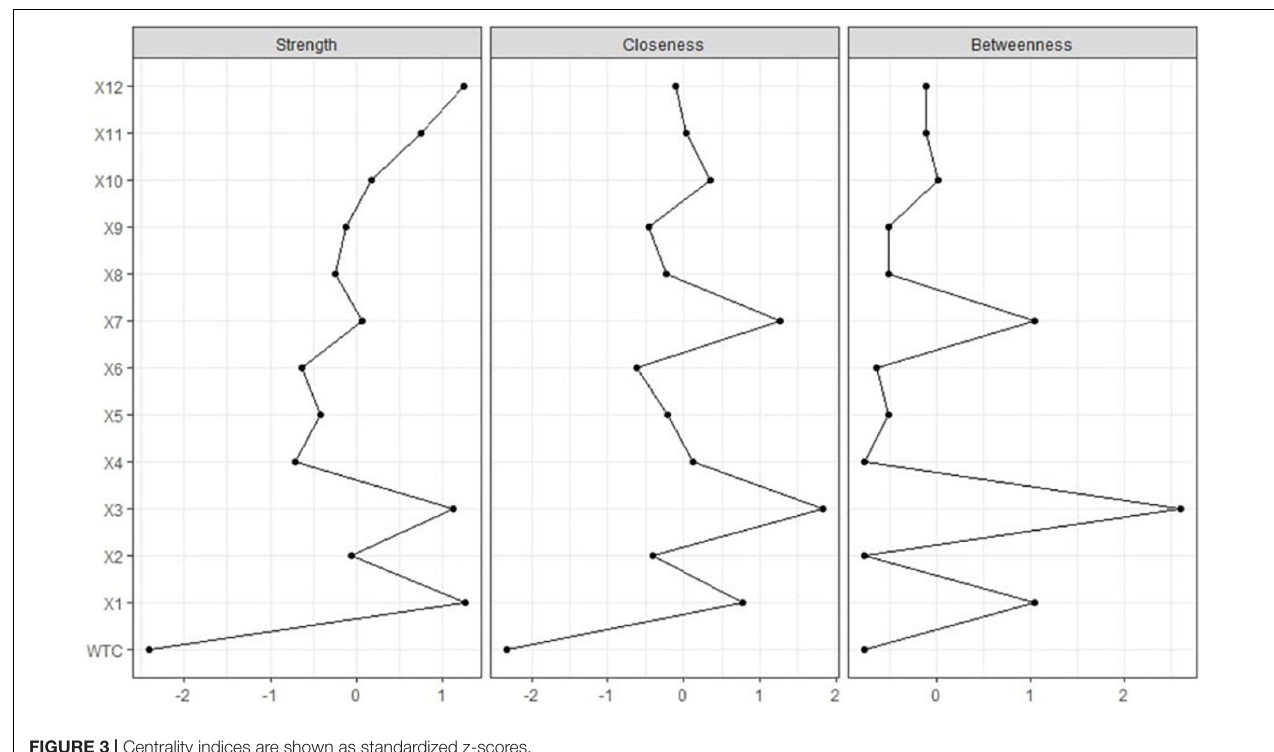
FIGURE 3 | Centrality indices are shown as standardized z-scores.